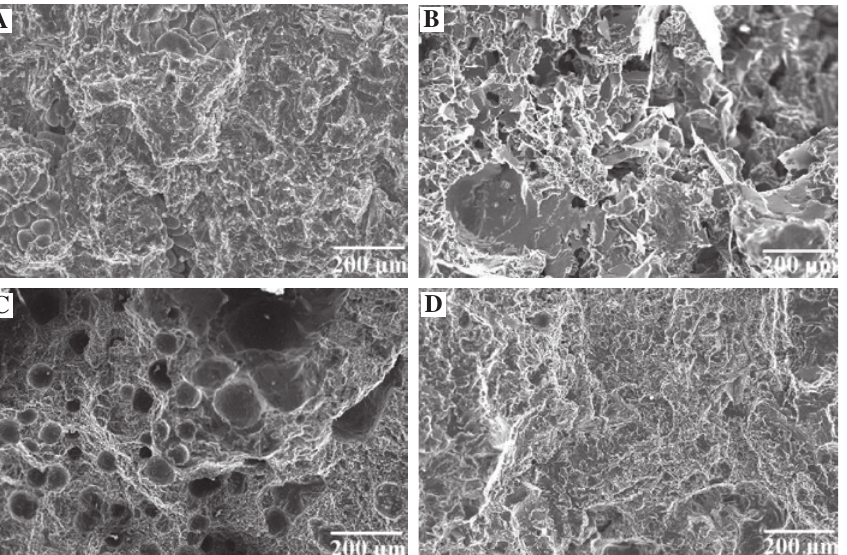
Figure 8: Fractographs of tensile specimens (A) unreinforced alloy (B) homogeneous composite (C) FGM – outer section and (D) FGM – inner section.